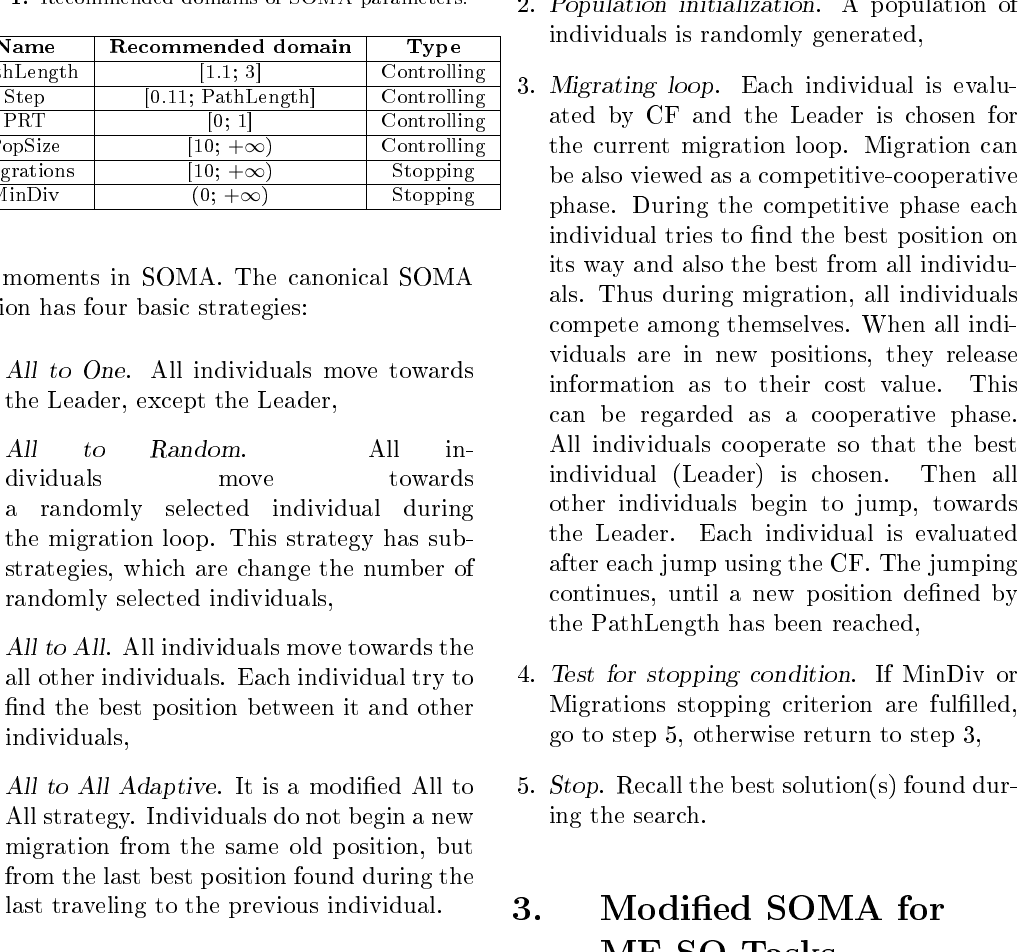
Tab. 1: Recommended domains of SOMA